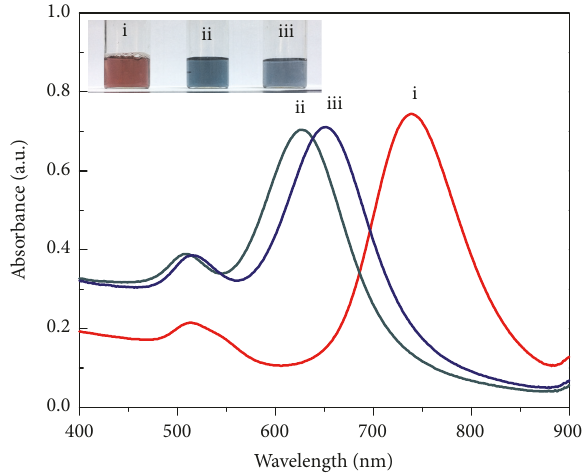
Figure 1: UV-vis absorption spectra of (i) CTAB-protected AuNRs, (ii) Au-HgNRs, and (iii) Au-HgNRs after addition of sulfide anions. The inset image shows the colorimetric